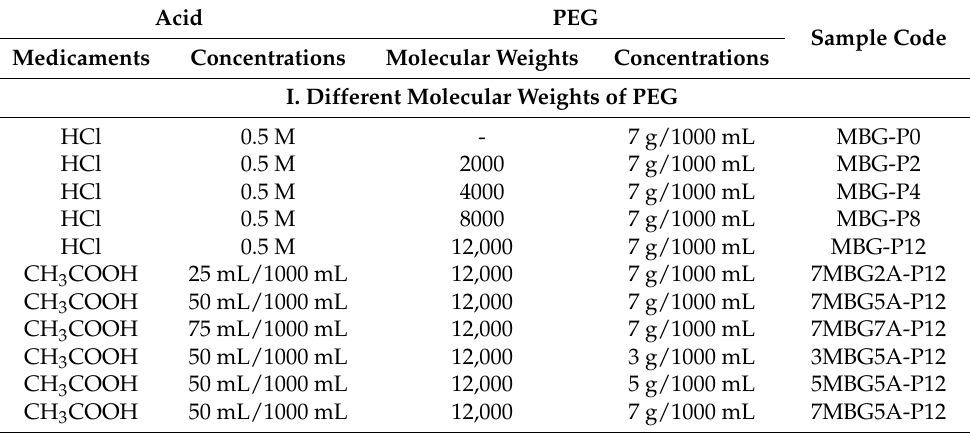
Table 2. The synthesis conditions of mesoporous bioactive glass (MBG) and the sample code used in this